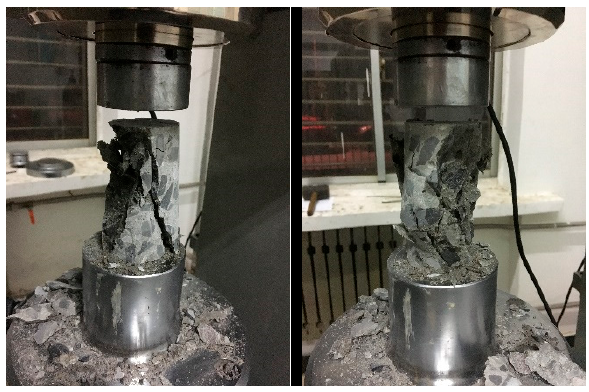
Figure 15. Typical failure modes of plain concrete under a dynamic load.